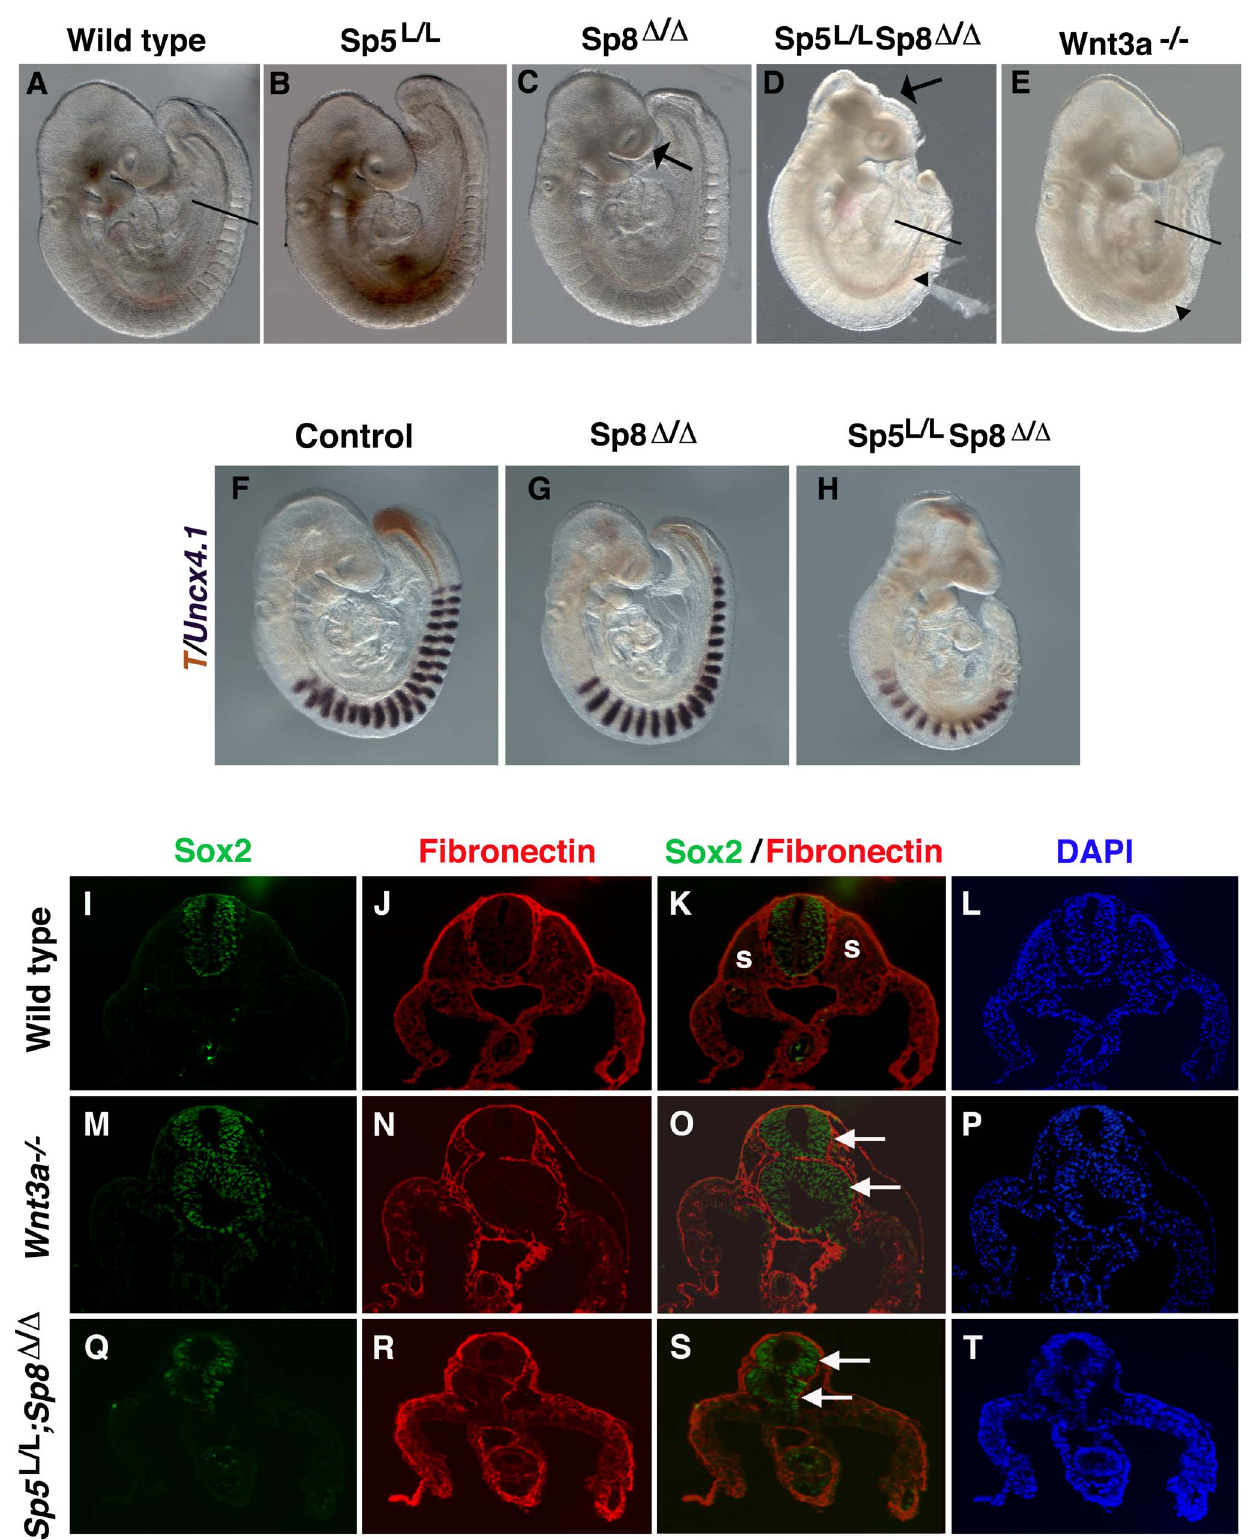
Figure 5. Sp5;Sp8 double mutants phenocopy single Wnt3a 2 / 2 mutants. Brightfield images depicting wild type (A), Sp5 LacZ/LacZ (B) Sp8 D / D , (C), Sp5 LacZ/LacZ ;Sp8 D / D (D), and Wnt3a 2 / 2 (E) mutant phenotypes at E9.5. Arrows in (C) and (D) indicates the open anterior neuropore. Arrowheads in (D) and (E) indicate position of last formed somite. (F–H) Two-color WISH analysis of somite polarity ( Uncx4.1) and tailbud progenitor ( T) markers in wt and mutant embryos at E9.5. F) Normal T expression in the PS and posterior PSM in control embryos. T was severely down regulated in Sp8 D / D embryos (G), and completely absent from Sp5 LacZ/LacZ ;Sp8 D / D mutants (H). (I–T) Immunofluorescence analysis of Sox2 and Fibronectin protein